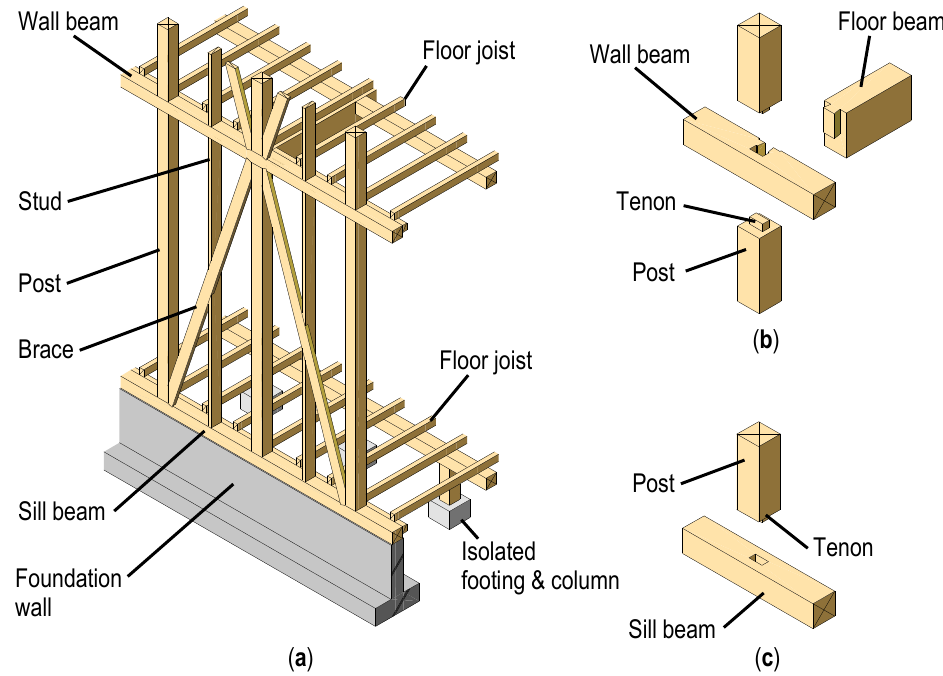
Figure 1. The typical framing of a common Japanese TF detached house: ( a ) the framing of the outer wall; ( b ) the connection around the wall beam; ( c ) the connection around the sill beam.